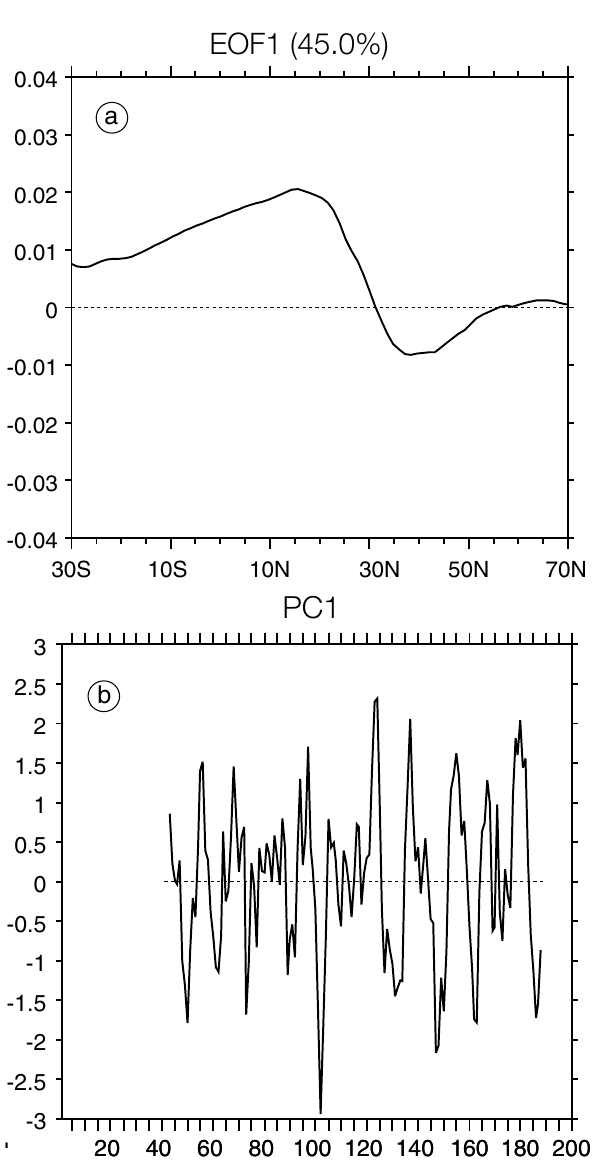
Fig. 6a,b. a) EOF1 (PW: 10 15 W), and (b) PC1 of low frequency OHT for the ECHAM4T30/OPA simulation.